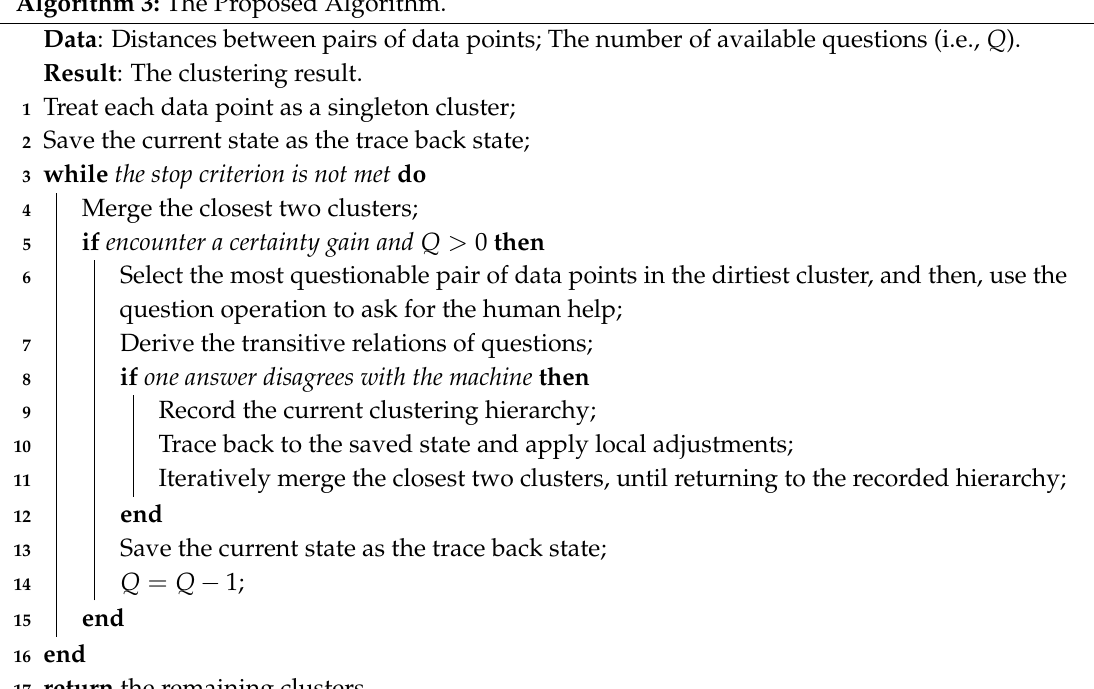
Algorithm 3: The Proposed